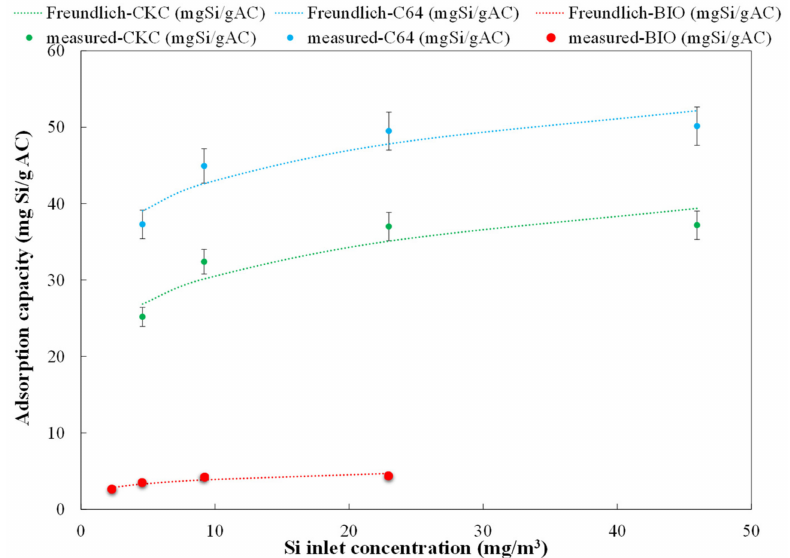
Figure 4. Freundlich isotherm for D4 removal with biochar, C64, and